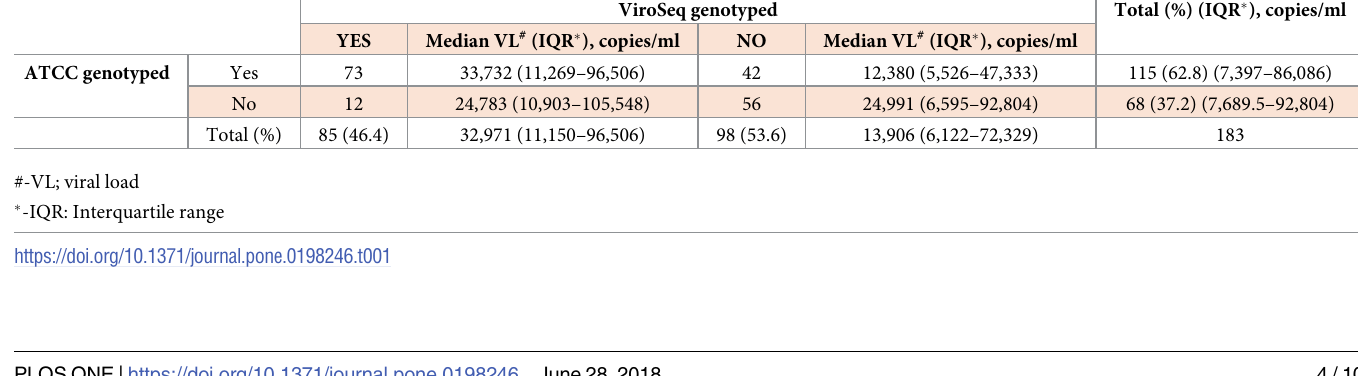
Table 1. Comparing HIV-1 Drug Resistance Genotyping performance between ATCC and ViroSeq methods with different viral load levels. ViroSeq